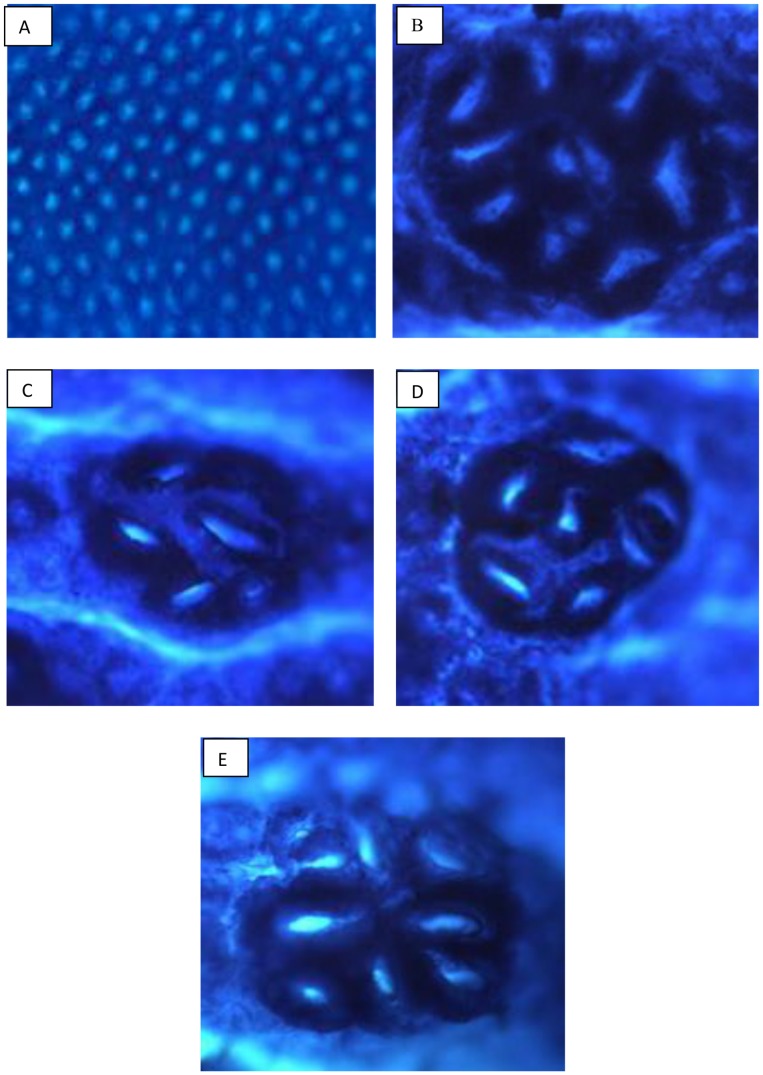
Effects of A. ilicifolius on AOM-induced ACF in rat colon.Topographic views of ACF in methylene blue staining of rat colonic tissue showing: (A) Normal crypts from rats treated with 10% Tween 20, normal control. (B) AOM control group, with significant increases in the ACF numbers. (C) Reference group (5-Fluorouracil) + AOM. (D) 250 mg/kg A. ilicifolius + AOM. (E) 500 mg/kg A. ilicifolius + AOM. (10×).